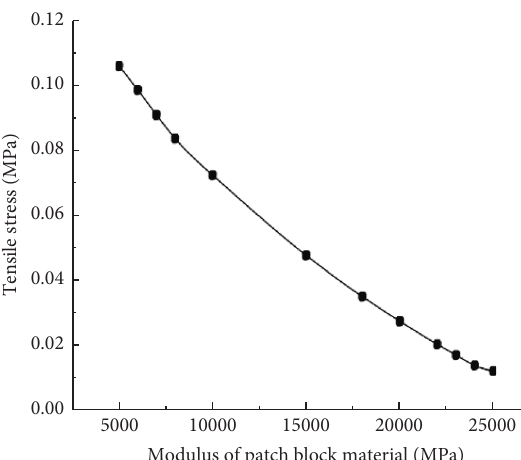
Figure 15: The effect of patch material modulus on shear stress of leveling layer.